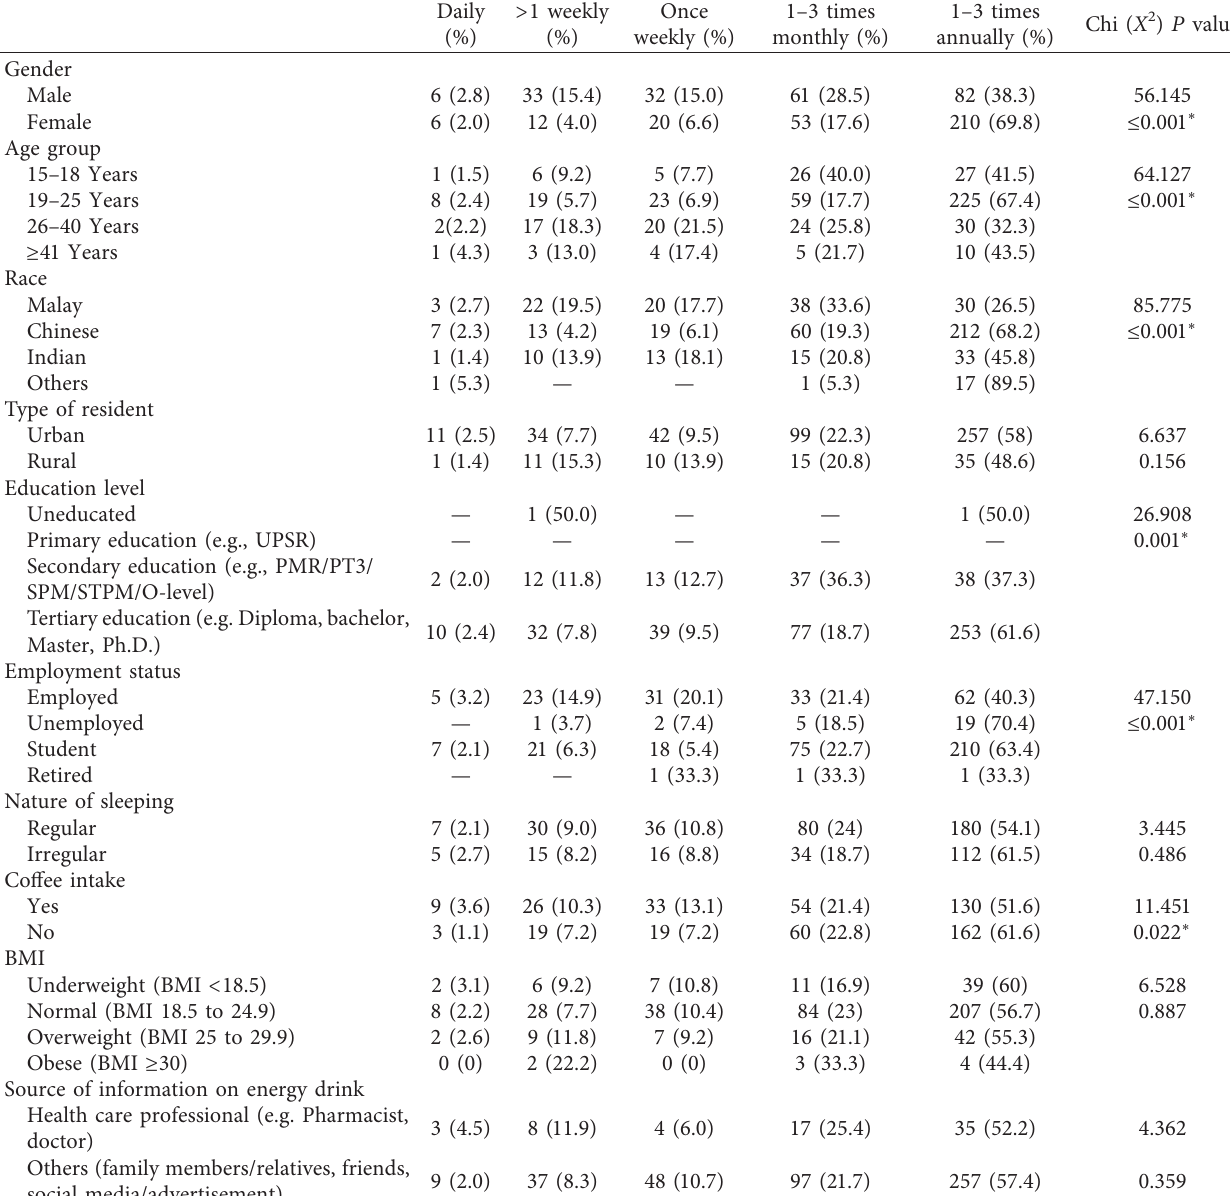
Table 6: Analysis of different average consumption groups of study participants and